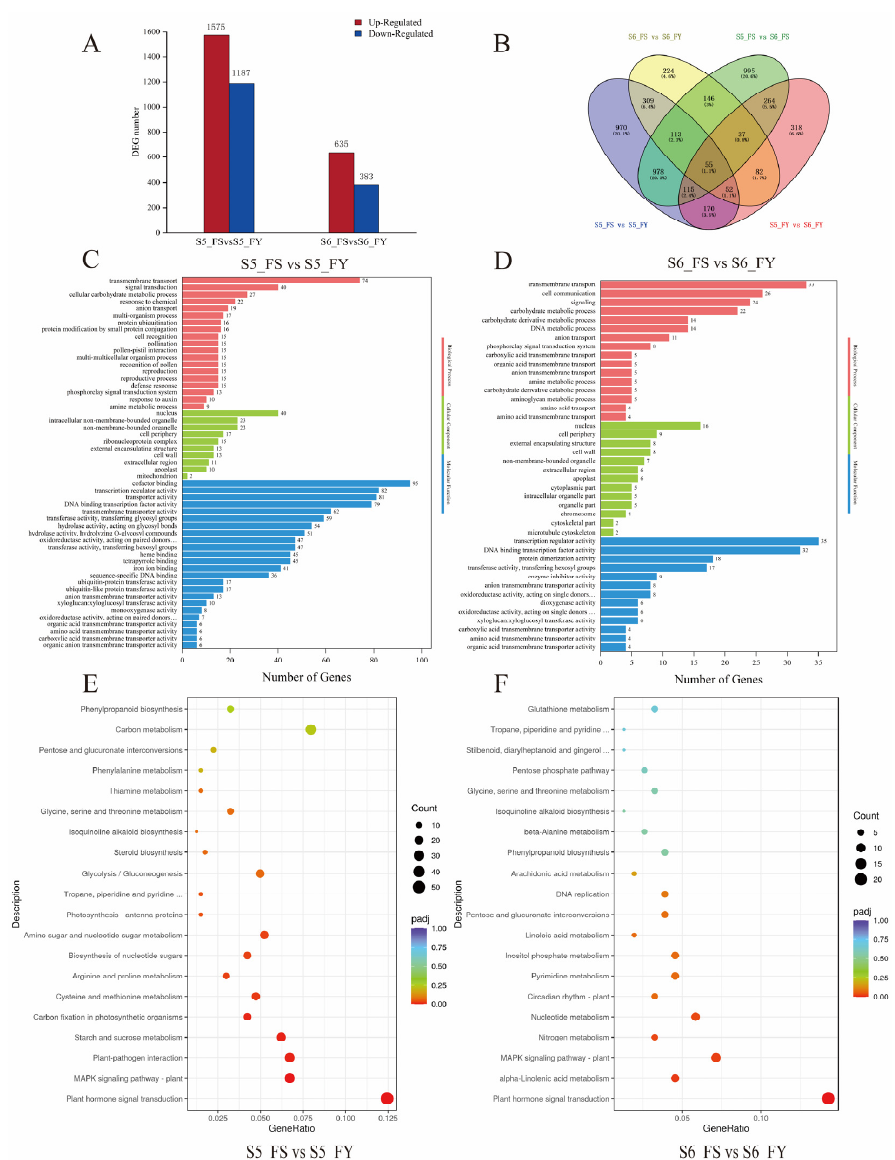
Figure 5. Differentially expressed genes (DEGs) in ‘Fengtangli’ plum from two pollination combi- nations. ( A ) Numbers of up-regulated and down-regulated DEGs of S5_FS vs. S5_FY and S6_FS vs. S6_FY. ( B ) Venn diagram of DEGs of S5_FS vs. S5_FY, S6_FS vs. S6_FY, S5_FS vs. S6_FS, and S5_FY vs. S6_FY. ( C ) GO and (D) KEGG pathway enrichment analysis of DEGs of S5_FS vs. S5_FY and S6_FS vs. S6_FY.